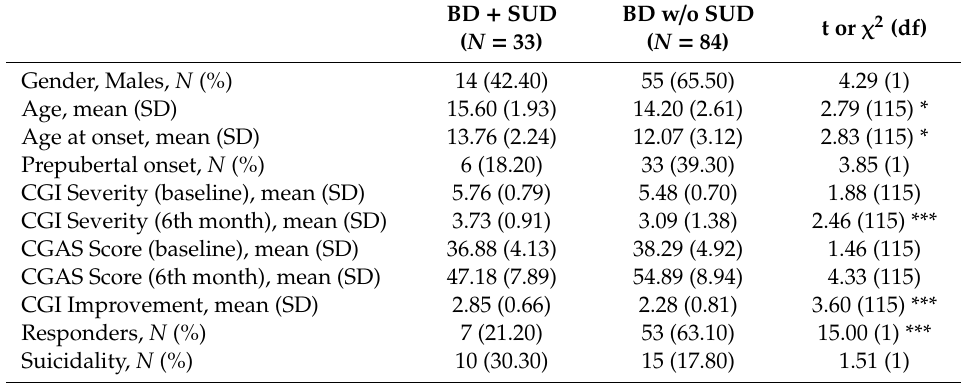
Table 4. Comparisons between patients with ( N = 33) and without substance use disorder ( N =